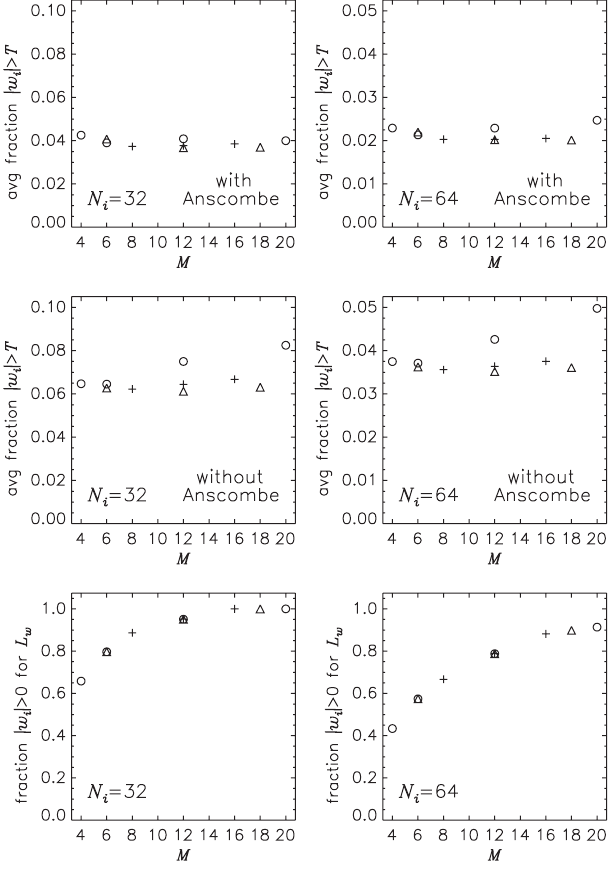
FIG. 20. Average fraction of wavelet coefficients retained to store a particle distribution in a simulation of the Fermilab/ NICADD photoinjector done with IMPACT-T with PCG with (cid:4) ppg (cid:4) 4 : 58 : with the Anscombe transformation (top row), N ppg without the Anscombe transformation (middle row). The bottom row shows the number of nonzero wavelet coefficients in the Laplacian operator in wavelet space. The left column shows (cid:4) 32 ( N (cid:4) 125 000 particles) and right N N i 1 000 000 particles). The size of the compact support of the wavelet family ( M ) is given on the abscissa for Daubechies wavelets of order 2, 3, 6, and 10 (empty circles), symlets of order 4, 6, 8 (crosses), coiflets of order 1, 2, 3